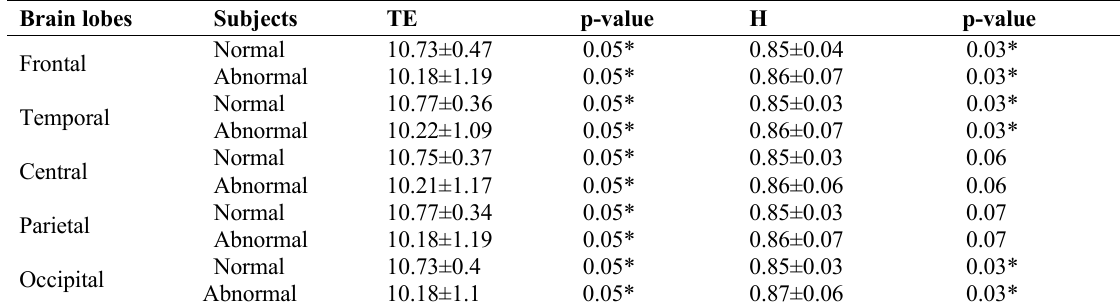
Table 1, The average values (Mean ± SD) of EEGs for the normal control subjects and epileptic patients over the brain regions. Significant group differences are marked with an